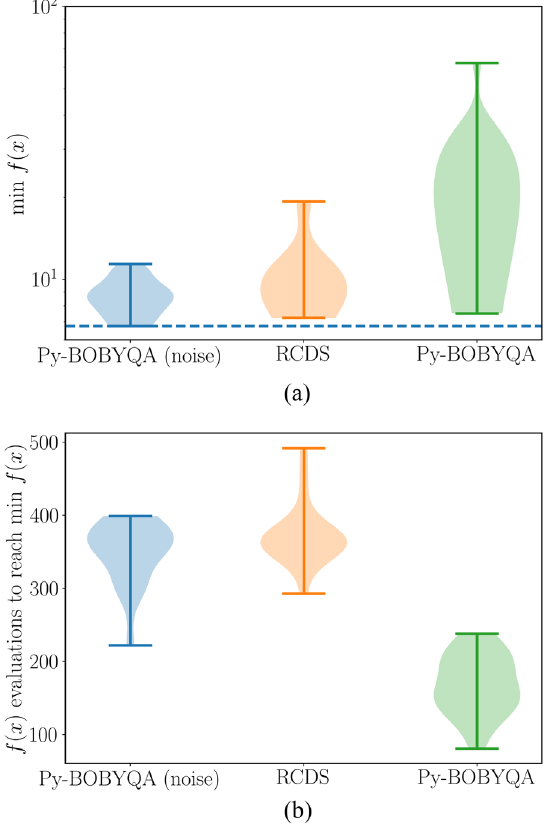
FIG. 9. (a) The minimum objective function [ f ð x Þ ] values from the minimization of the injection-point beam size by optimizing sextupole and octupole transverse offsets using (left) Py-BO- BYQA ( objfun_has_noise = True ), (center) RCDS, and (right) Py-BOBYQA ( objfun_has_noise=False ). (b) The number of function evaluations to reach the minimum f ð x Þ . The algorithms were tested on 20 error seeds; the minimum and maximum values for each are indicated.